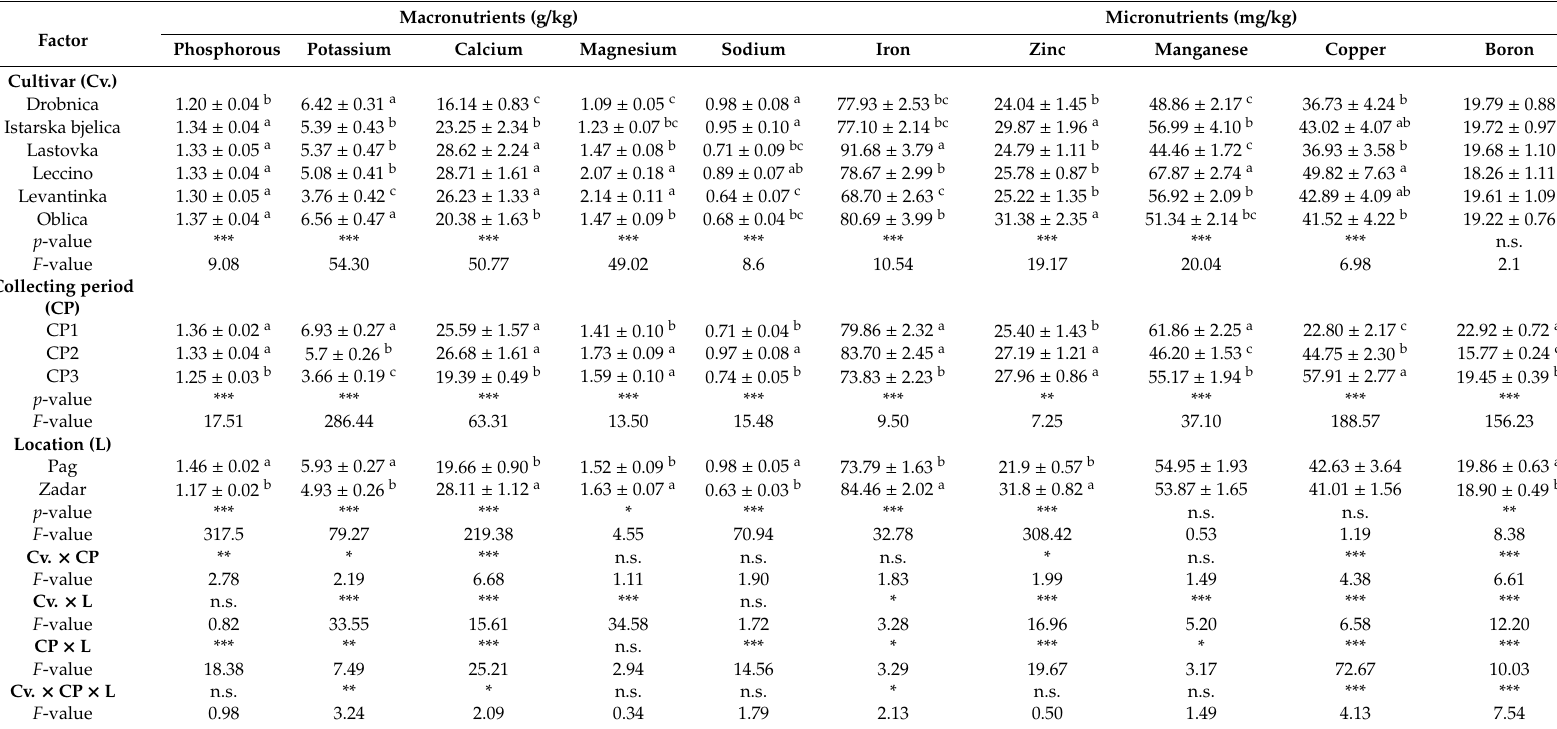
Table 3. Concentrations of macro (g / kg) and micronutrients (mg / kg) in leaves of six olive cultivars collected at three di ff erent periods (CP1—October 2017, CP2—January 2018, and CP3—March 2018) in two